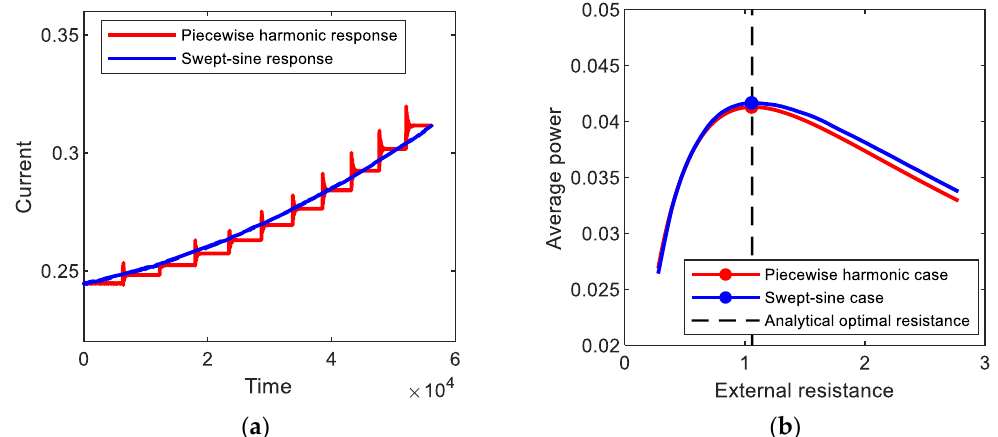
Figure 13. ( a ) Amplitudes of the output current responses to (red line) piecewise harmonic and (blue line) swept-sine excitations, which are obtained for the period-3 T interwell motions of the bi-stable electromagnetic energy harvester, and ( b ) average output powers evaluated with the variation of the external load resistance.